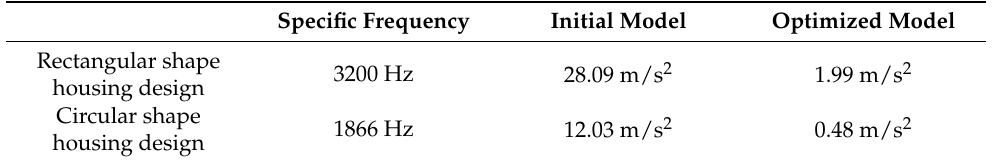
Table 2. Comparison of acceleration response of Rectangular and Circular shape housing